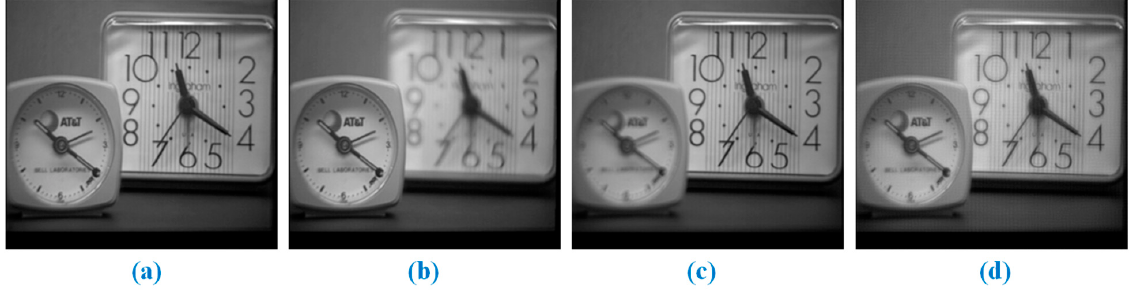
Figure 9. (Clock): ( a ) original image; ( b , c ) multi-focus input images; and ( d ) proposed fusion. Table 3. The outcomes for the clock image and comparisons with existing techniques in the litera- ture ([21]).